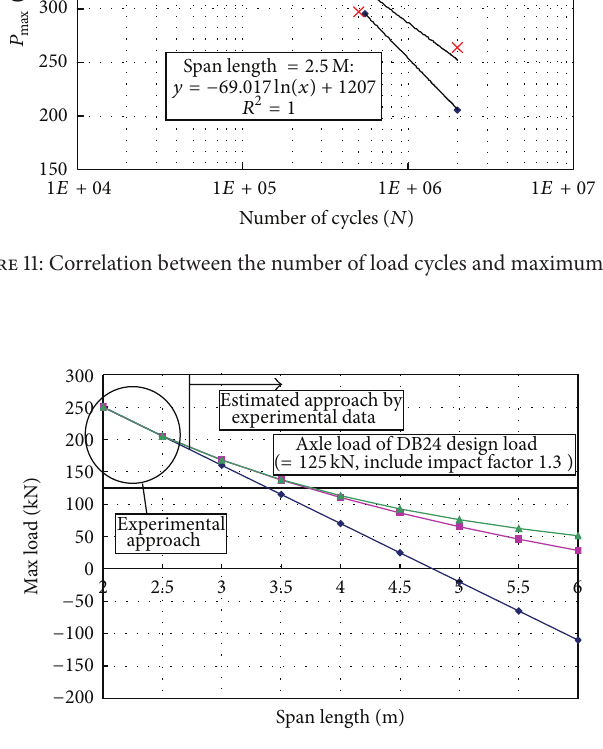
Linear func. Log func. Figure 12: Estimation on the maximum load by span